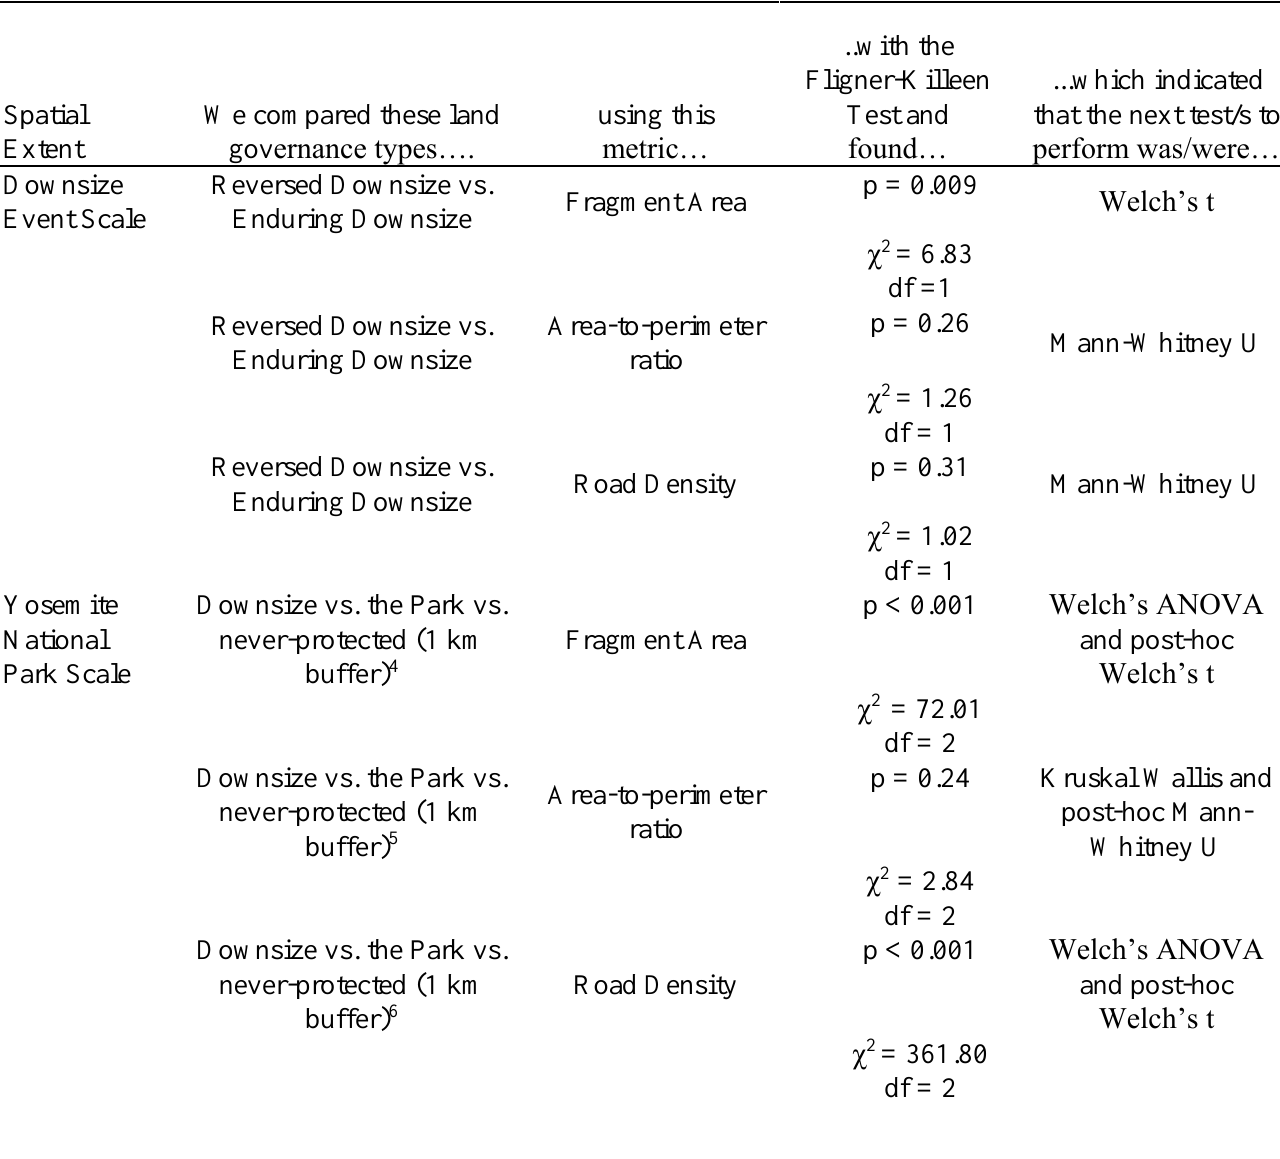
Table A1.8: Results of Fligner-Killeen tests for homoscedasticity for all land cover types indicating which statistical test(s) to perform next at all three spatial scales